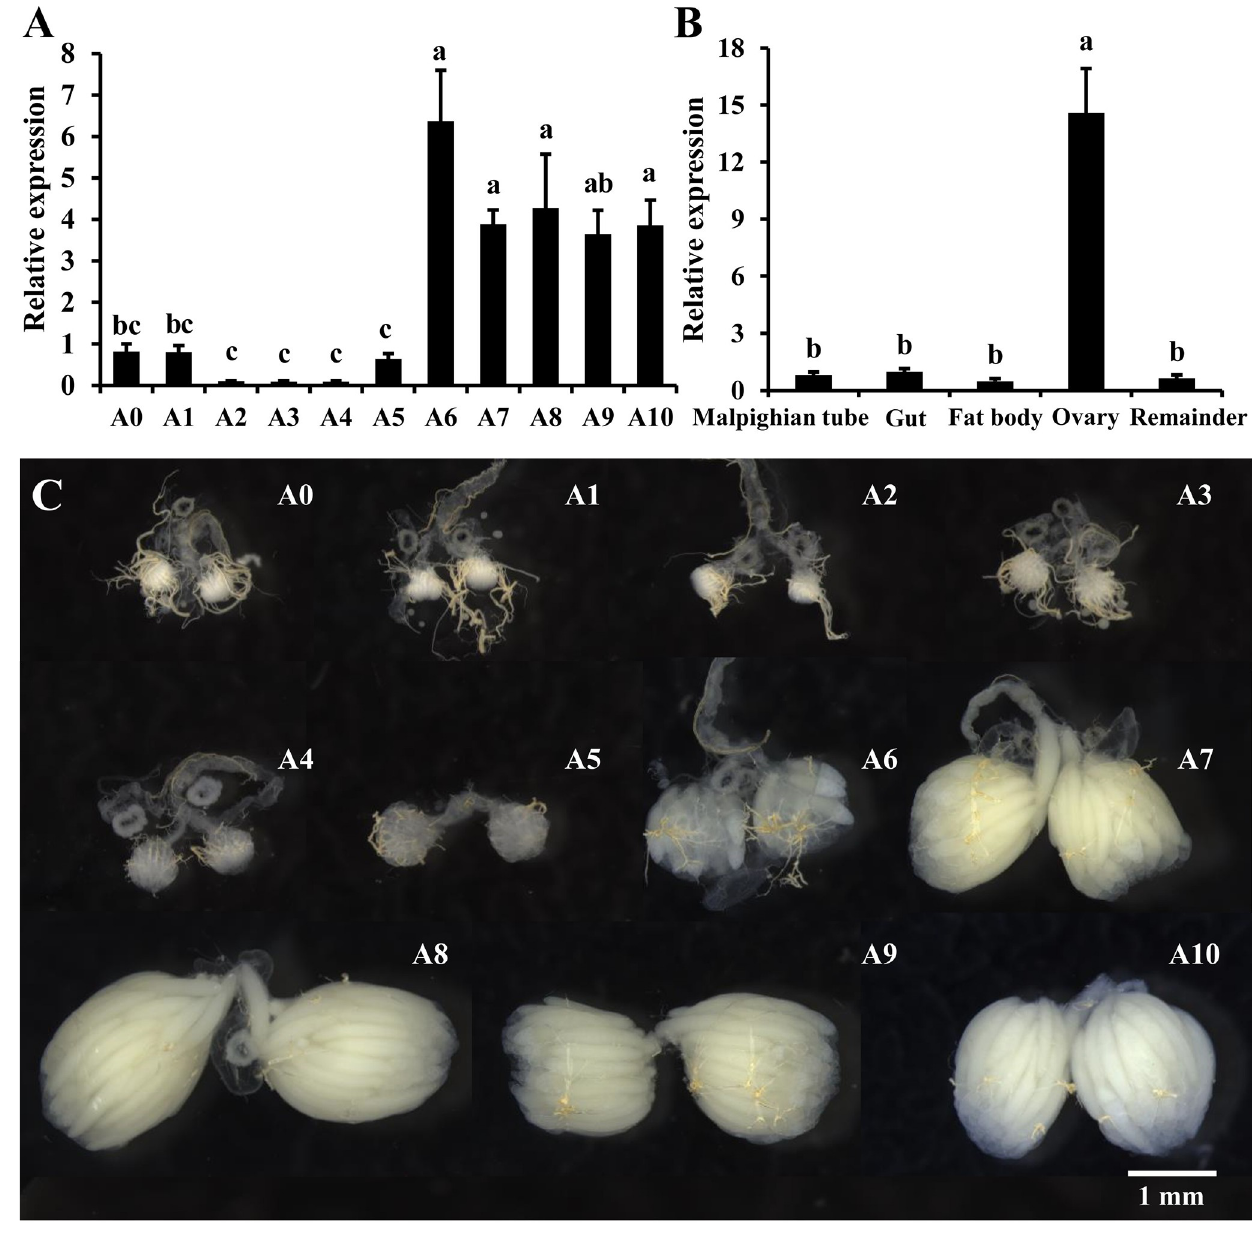
Fig 1. Spatiotemporal expression of miR-309a in B . dorsalis . (A) Temporal expression of miR-309a in the ovary. (B) Tissue expression of miR-309a, including Malpighian tubules, gut, fat body, ovary, and remainder (the remaining tissue). (C) Ovarian development during A0–A10. A0–A10: ovarian samples of adults from 0 d to 10 d. Data are means ± SE (error bars) of four biological replications. U6 as a reference gene was used to normalize the expression of miR-309a via qBASE software. Different letters above the bars indicate significant differences of miR-309a in different tissues or developmental stages of the ovary (Tukey HSD, ANOVA, P < 0.05). negative control (S2B Fig). Further quantitative real-time PCR (qPCR) analysis revealed that the temporal expression profiles of these candidate targets were negatively correlated with that of miR-309a in the ovary (Fig 3C). In contrast to the temporal expression profile of miR-309a in the ovary, where the expression of this miRNA spiked later during ovarian development, the expression levels of pnr and tret were relatively high during early ovarian development and